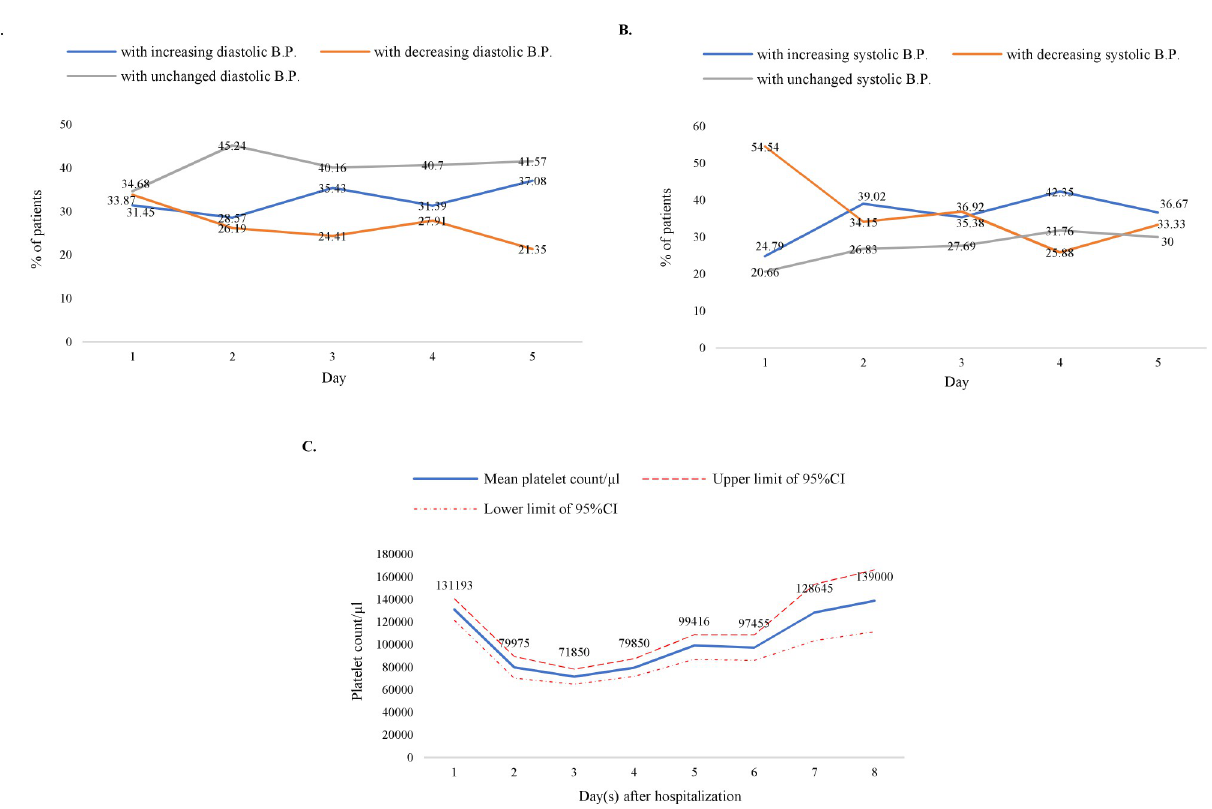
Fig 3. Temporal trends of dengue patient’s clinical parameters and correlation of these parameters with recovery time. (A) Changing tendency of diastolic blood pressure after day(s) of hospitalization. (B) Changing tendency of systolic blood pressure after day(s) of hospitalization. (C) Mean platelet count of patients versus days after hospitalization.